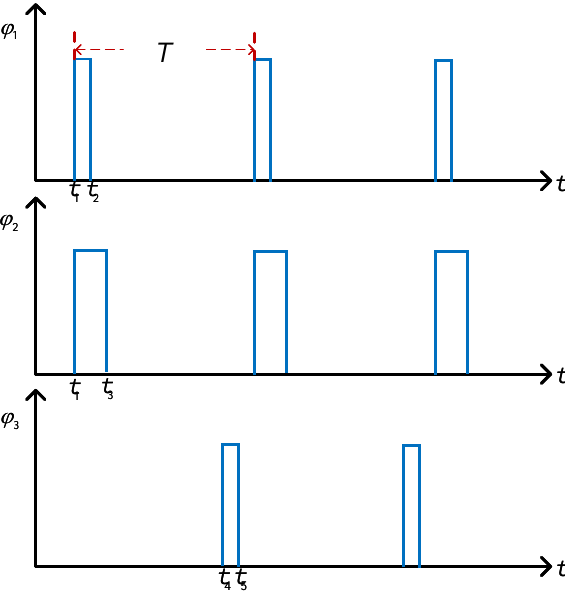
Figure 4. The diagram of timing phase. As shown in Figure 4, there are three phases named ϕ 1 , ϕ 2 , and ϕ 3 , which control the switches named φ 1 , φ 2 , and φ 3 in Figure 5, respectively. The working period is marked as T in Figure 4.